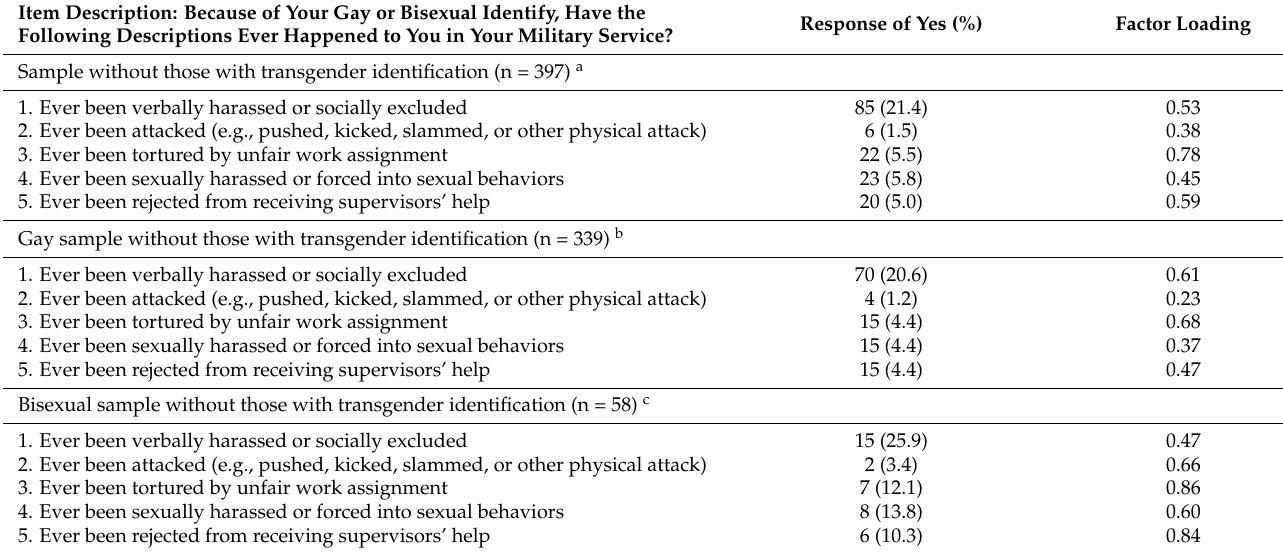
Table 3. Exploratory factor analysis results of the Enacted Sexual Stigma Experiences Scale in Military Service (ESSESiMS).